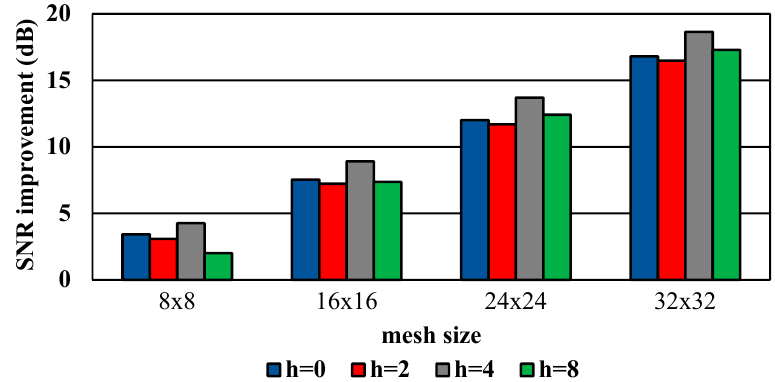
Figure 13. SNR improvement in an average basis for the 1st, 2nd and 3rd longest paths of the SOA-enabled HONoC according to different ℎ and network sizes.